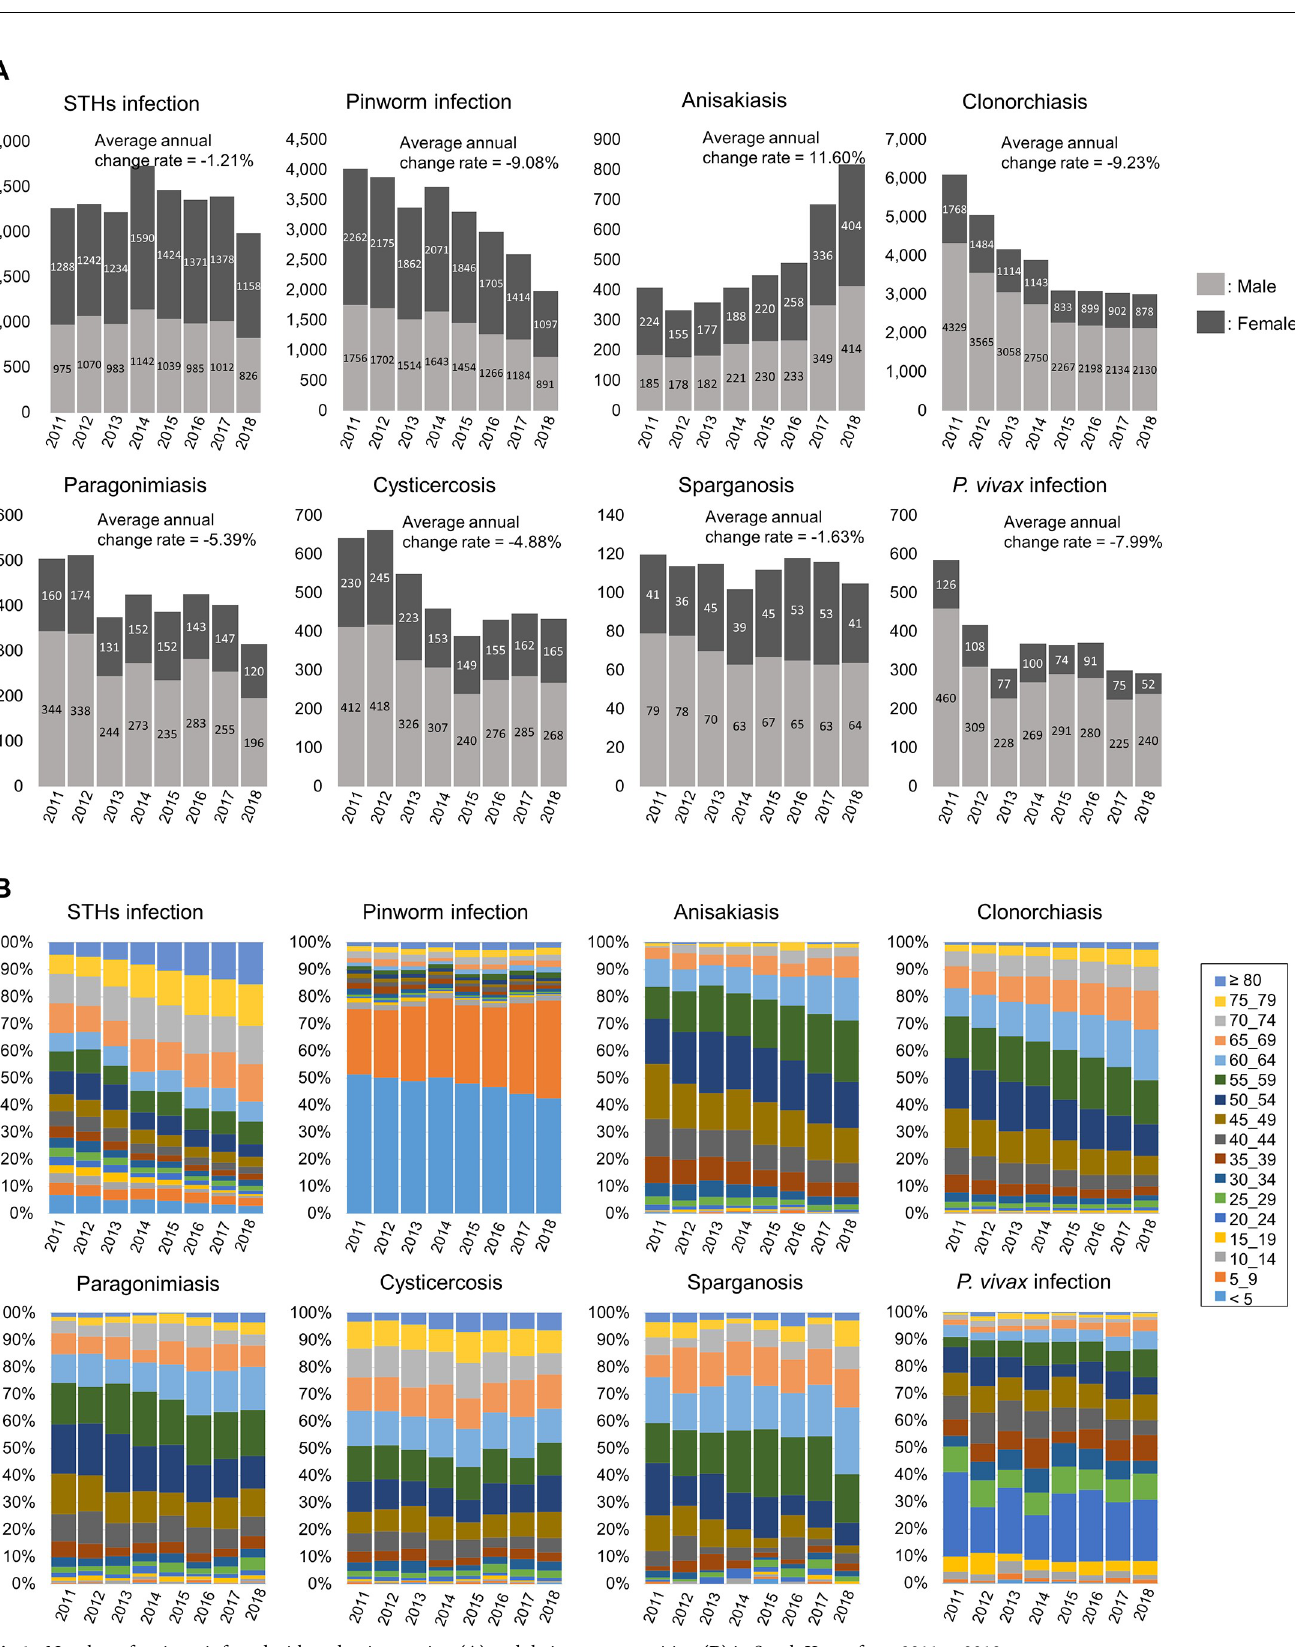
Fig 1. Number of patients infected with endemic parasites (A) and their age composition (B) in South Korea from 2011 to 2018. https://doi.org/10.1371/journal.pone.0225508.g001 PLOS ONE | https://doi.org/10.1371/journal.pone.0225508 November26,